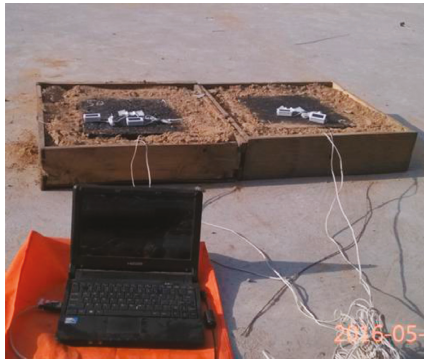
Figure 3: Test system of outdoor